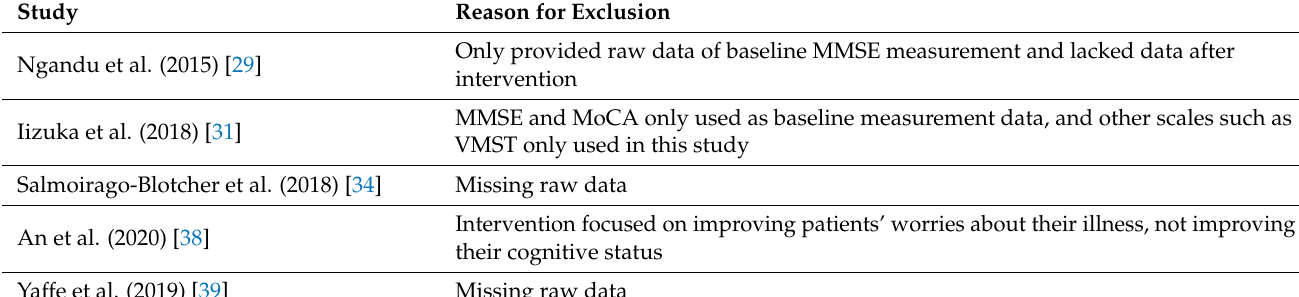
Table 2. Reasons for the exclusion of studies from the meta-analysis.